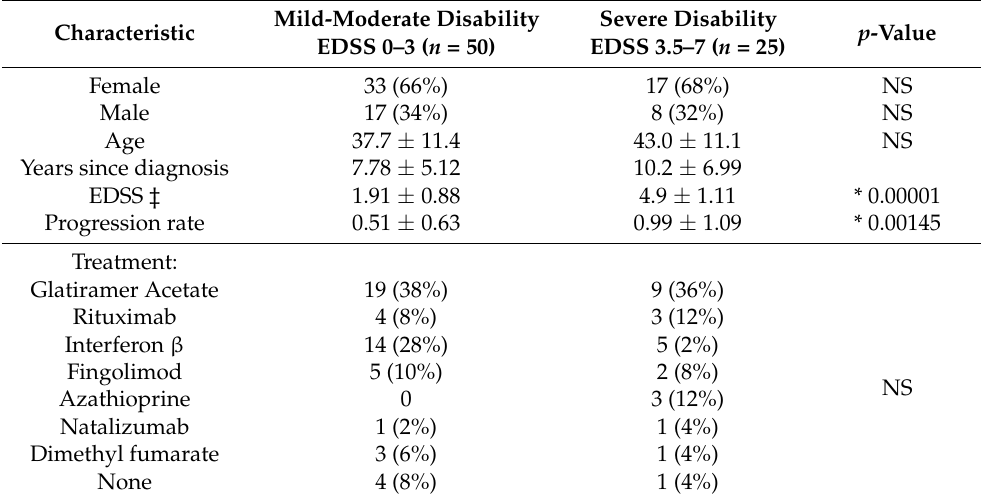
Table 1. Demographic characteristics of RRMS patients and their pharmacological treatments. Mild-Moderate Disability Characteristic EDSS 0–3 ( n = 50)